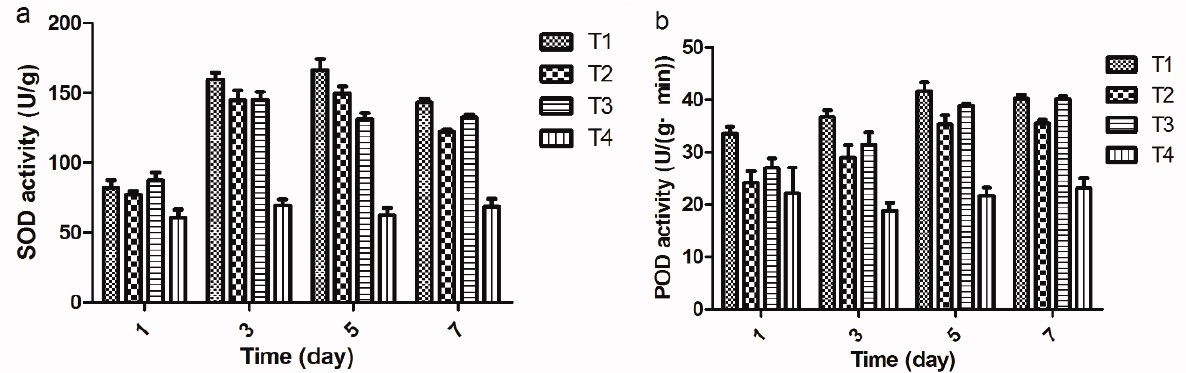
Figure 2. The changes of SOD ( a ) and POD ( b ) activities (The data presented are the mean ± SD). T1 : Xoo + Compound 2-(methyl sulfonyl)-5-(4-fluorophenyl)-1,3,4-oxadiazole; T2 : Xoo + Bismerthiazol; T3 : Xoo ; T4 : Untreated blank